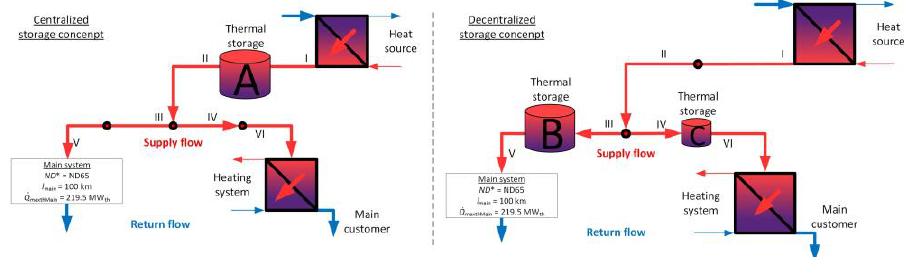
Fig. 2. Topographies of the centralized and decentralized storage concept